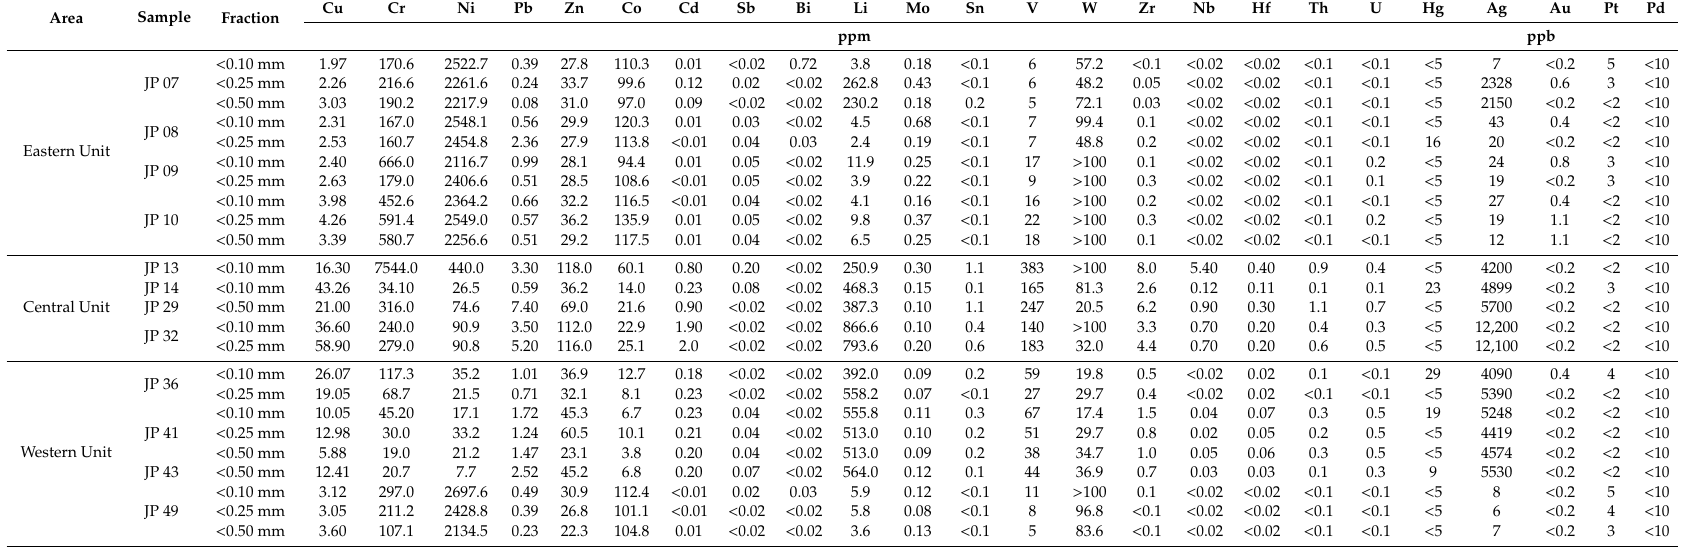
Table A1. Chemical compositions of heavy mineral fractions. ICP-MS / ES